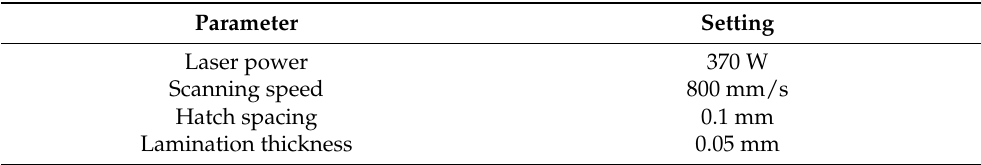
Table 1. Parameters used in the selective laser melting process.